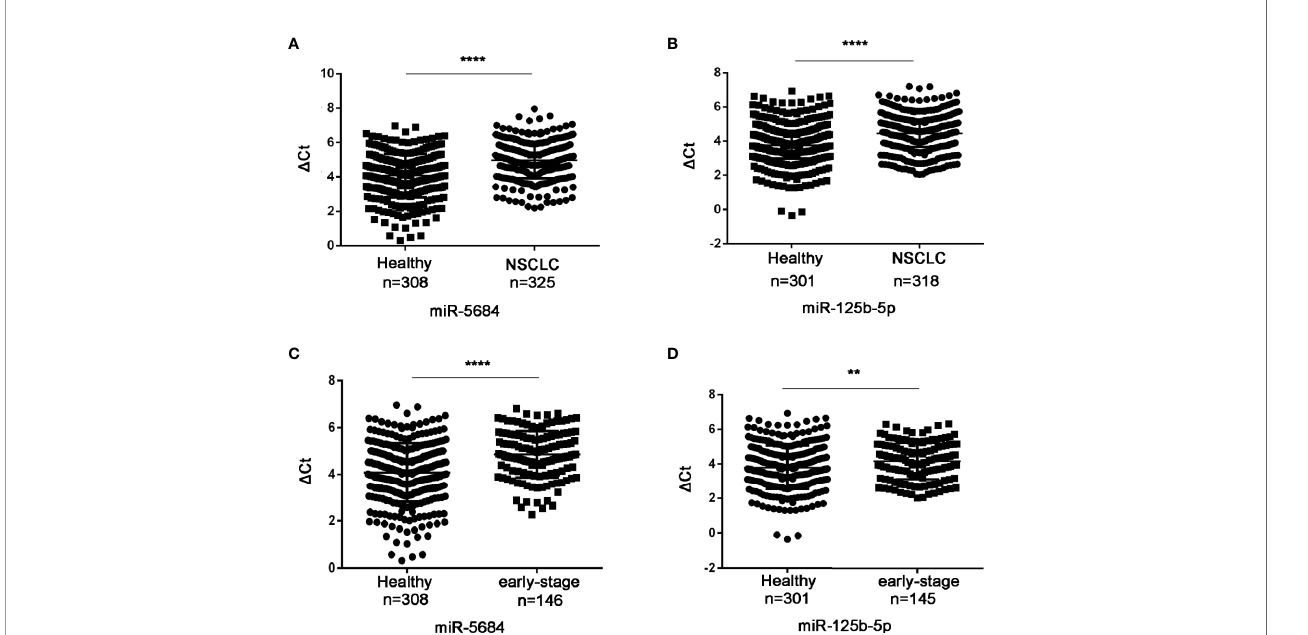
FIGURE 3 | Serum exosomal miR-5684 and miR-125b-5p are potential biomarkers of NSCLC. The expression levels of serum exosomal miR-5684 and miR-125b- 5p in (A) NSCLC patients and (B) healthy donors. The expression levels of serum exosomal miR-5684 and miR-125b-5p in (C) early-stage NSCLC patients and